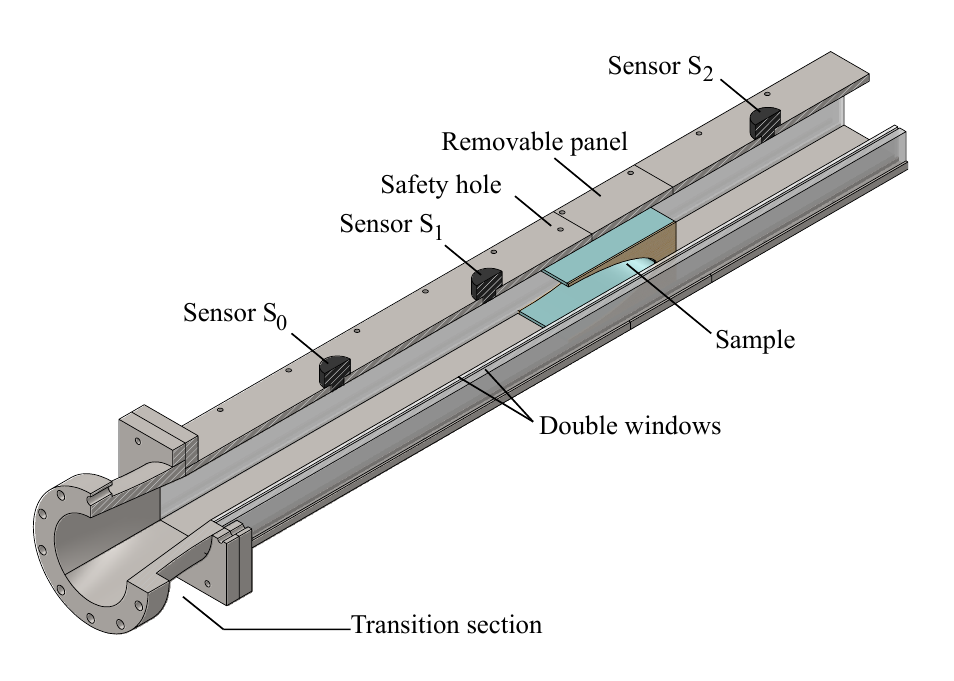
Figure 4. Pressure plot from the upstream sensor S Time interval ∆ t = 2 . 3 ms represents the time between the shock wave and the head of the reflected expansion wave. The arrow points at a reflection caused by a removable panel of the shock tube.